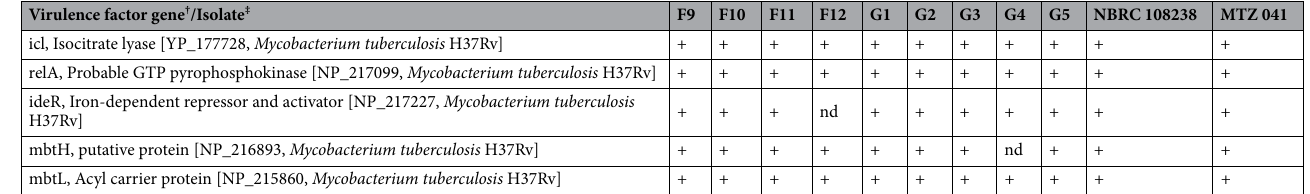
Table 2. Virulence factor genes present in Gordonia paraffinivorans a according to virulence factor database. a Mastitis isolates (n = 9) and NBRC 108238 and MTZ 041 strains; † Only virulence genes with percentage of coverage greater than 40% and percentage of identity greater than 75% to virulence factor database genes are present; + gene present; nd not detected; ‡ Field G. paraffinivorans mastitis isolates are marked as F9–F12 and